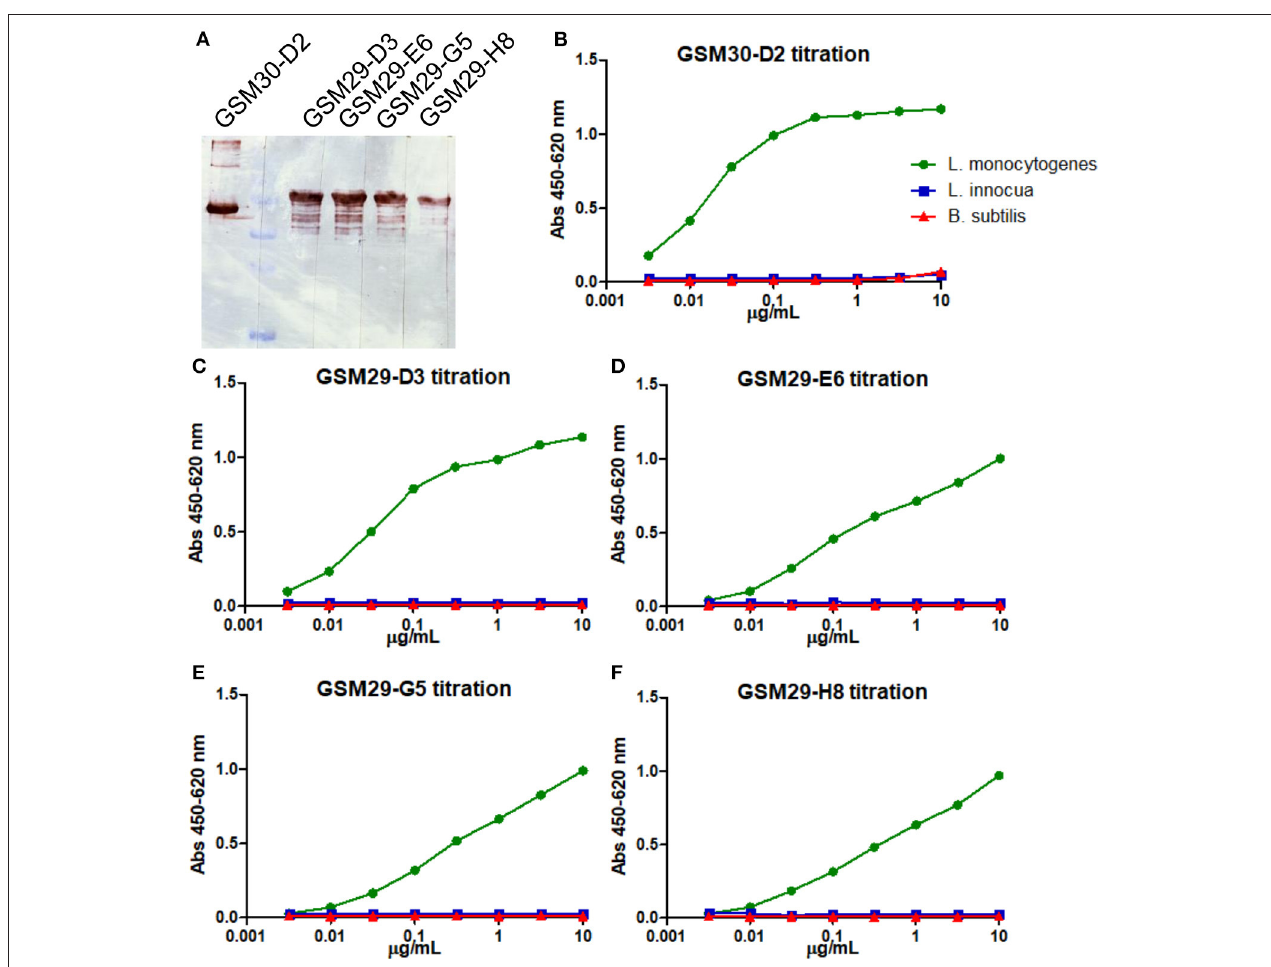
FIGURE 1 | Immunoblot and indirect ELISA for titration and initial specificity screening of the scFv-Fc antibodies against recombinant InlA and InlB. The five mAbs were diluted to 1 µ g/mL and tested against 1 µ g of the recombinant protein via immunoblot (A) . The anti-InlB scFv-Fc GSM30-D2 (B) , and the anti-InlA GSM29-D3 (C) , GSM29-E6 (D) , GSM29-G5 (E) , and GSM29-H8 (F) were tested against three strains coated alive onto ELISA plates: L. monocytogenes ATCC 7644 (green), L. innocua DSM 20649 (blue), and B. subtilis 168 NCIB 10106